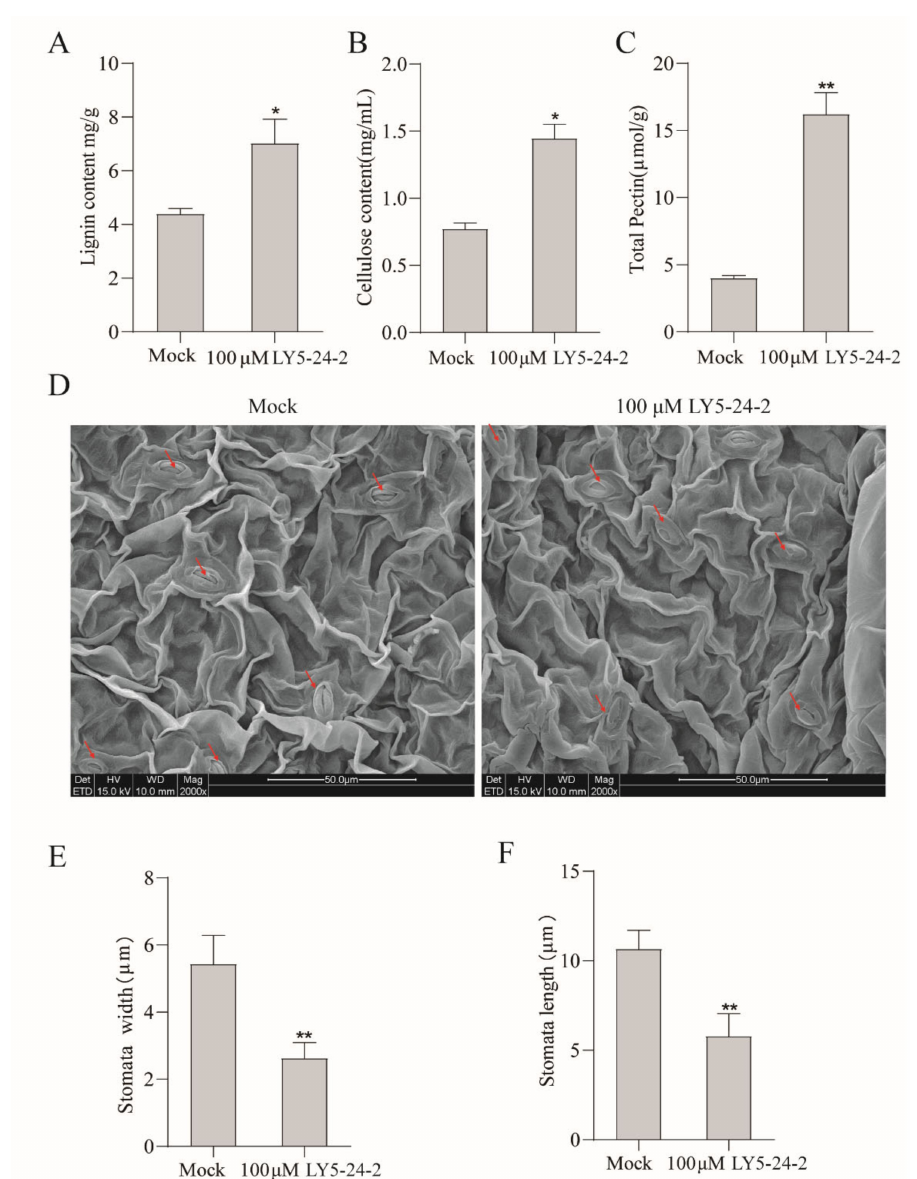
Figure 3. LY5-24-2 promoted the accumulation of A. thaliana cell wall components and the closure of stomata at 24 h after a treatment with 100 µ M of LY5-24-2. ( A ) Lignin content. ( B ) Cellulose content. ( C ) Total pectin content. ( D ) Changes in stomata (Red arrows indicated leaf stomata). ( E ) Stomatal width. ( F ) Stomatal Length. Data are shown as the mean of three biological replicates ± SD. The * represent significant difference (* p < 0.05, ** p < 0.01, Student’s t